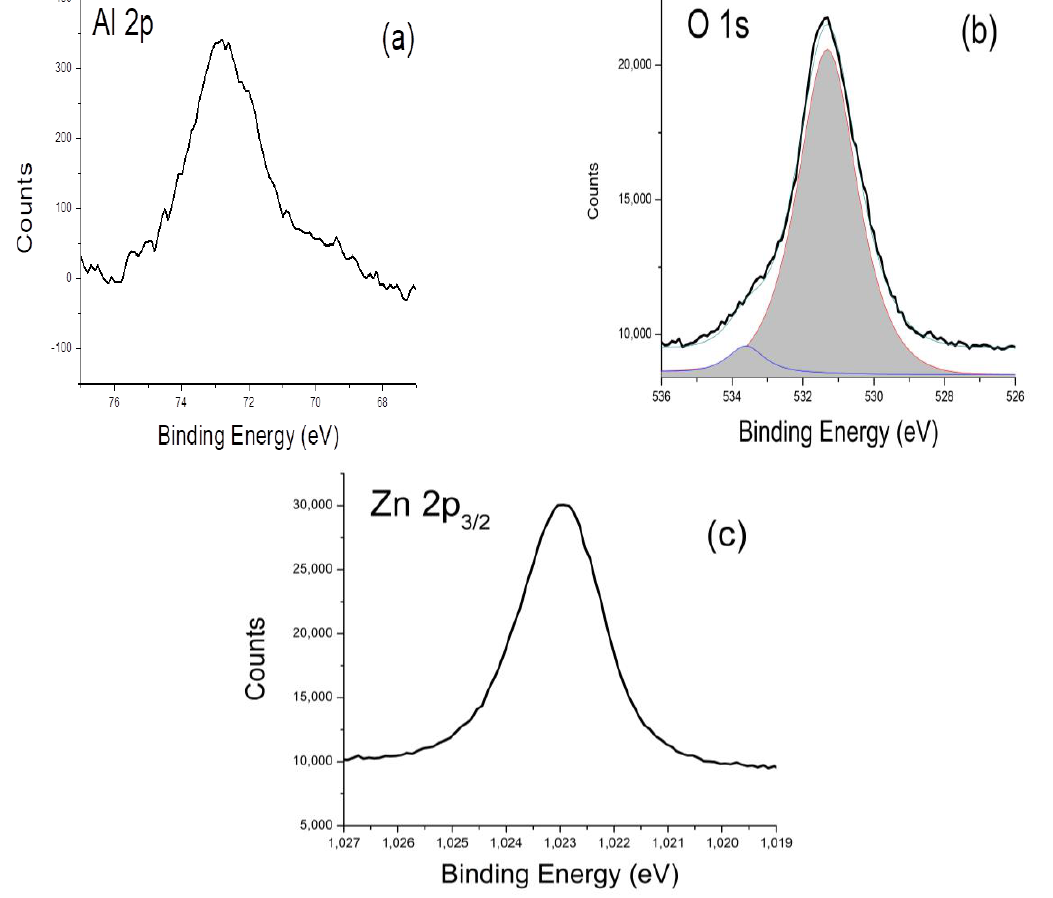
Figure 4. XPS spectra of Al 2 O 3 -ZnO nanostructures grown by PLD + RFMS. ( a ) Al 2p 3/2 ; ( b ) O1s: ( c ) Zn 2p 3/2 lines. ( c ) Zn 2p 3/2